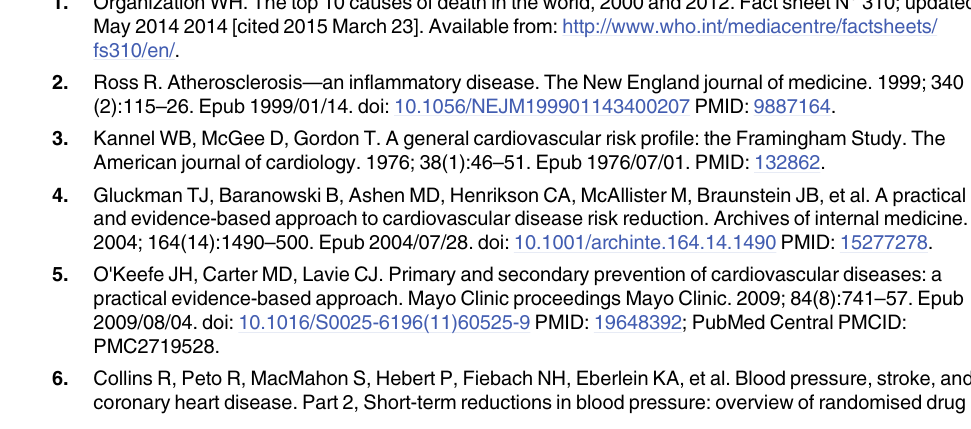
S1 Table. Excell file containing the full database for lipids (primary outcome) and blood pressure (secondary